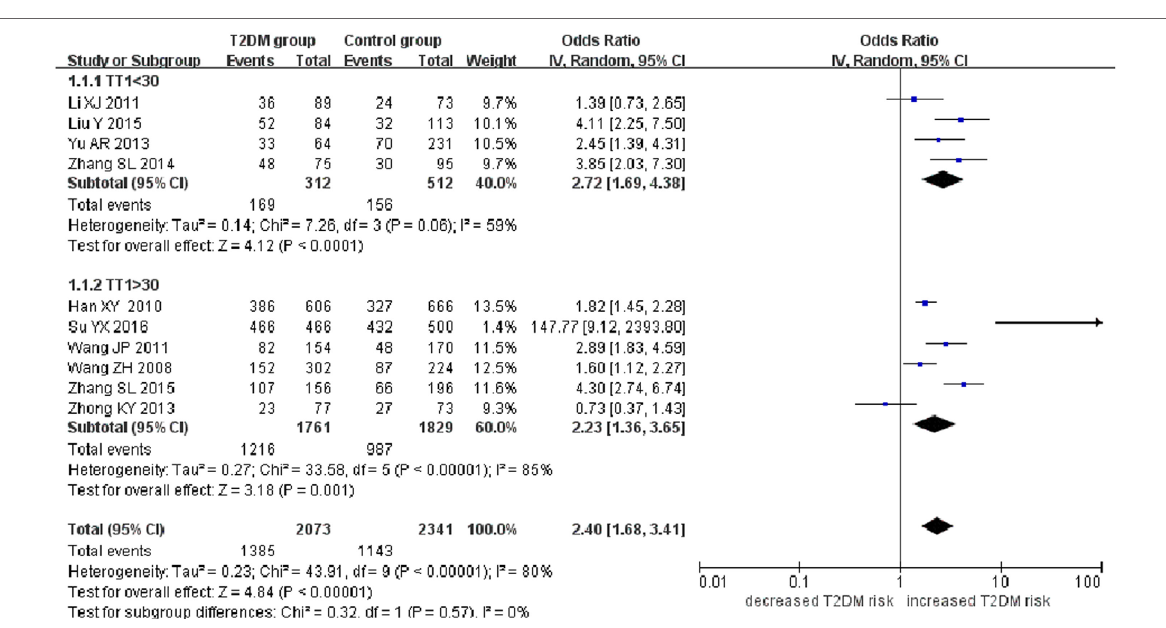
FiGURe 3 | Forest plot of type 2 diabetes mellitus associated with SLC30A8 gene rs13266634C/T polymorphism in the Chinese population under a dominant genetic model (CC vs. CT +